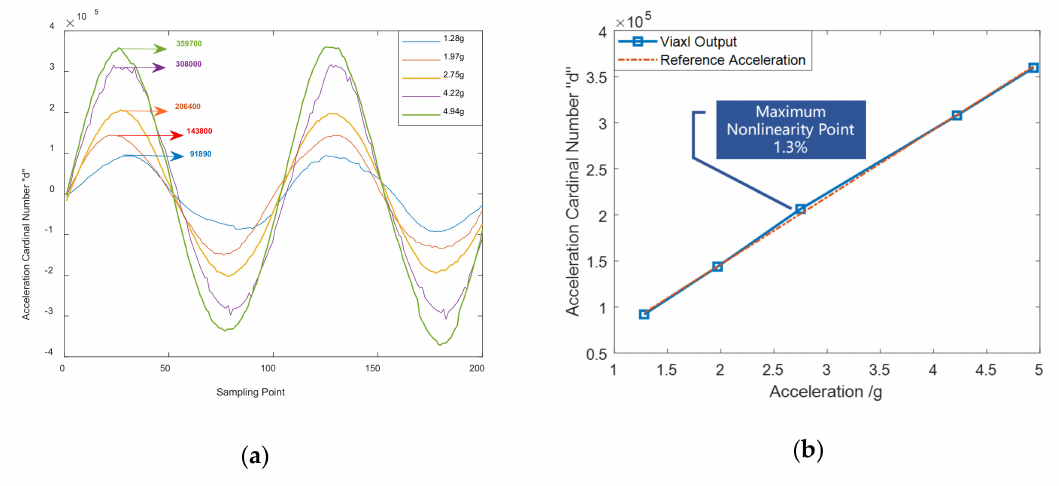
Figure 7. Nonlinearity verification of Viaxl at 20 Hz: ( a ) Time domain signal; ( b ) spectrum of 10–100 Hz Viaxl